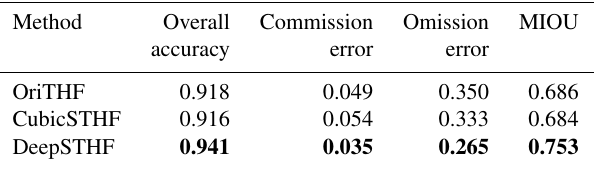
Table 5. The lead mapping results of the OriTHF, CubicSTHF, and DeepSTHF